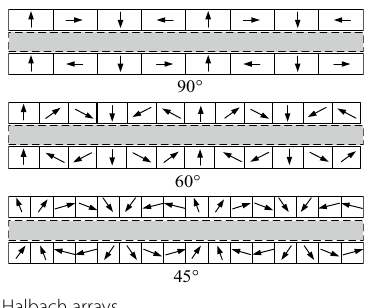
Figure 19 Halbach arrays